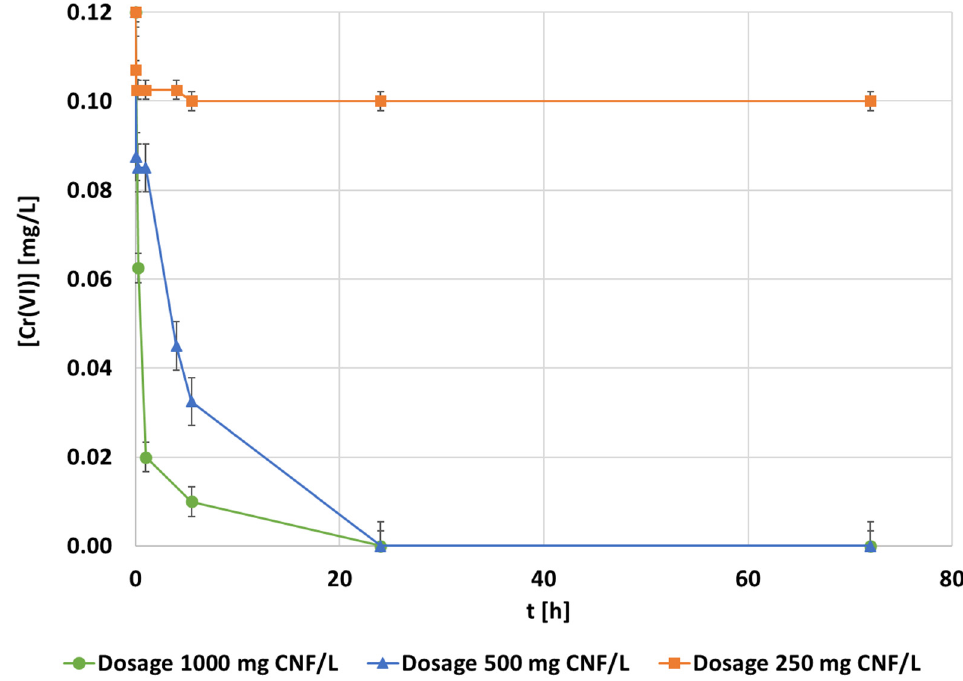
Figure 7. The evolution of the hexavalent chromium concentration [mg·L − 1 ] during adsorption with the CNF hydrogel at 0.1 mg·L − 1 of the chromium initial concentration, 1.5 mmol MTMS·g − 1 CNF, and pH 3 conditions under different adsorbent dosages.